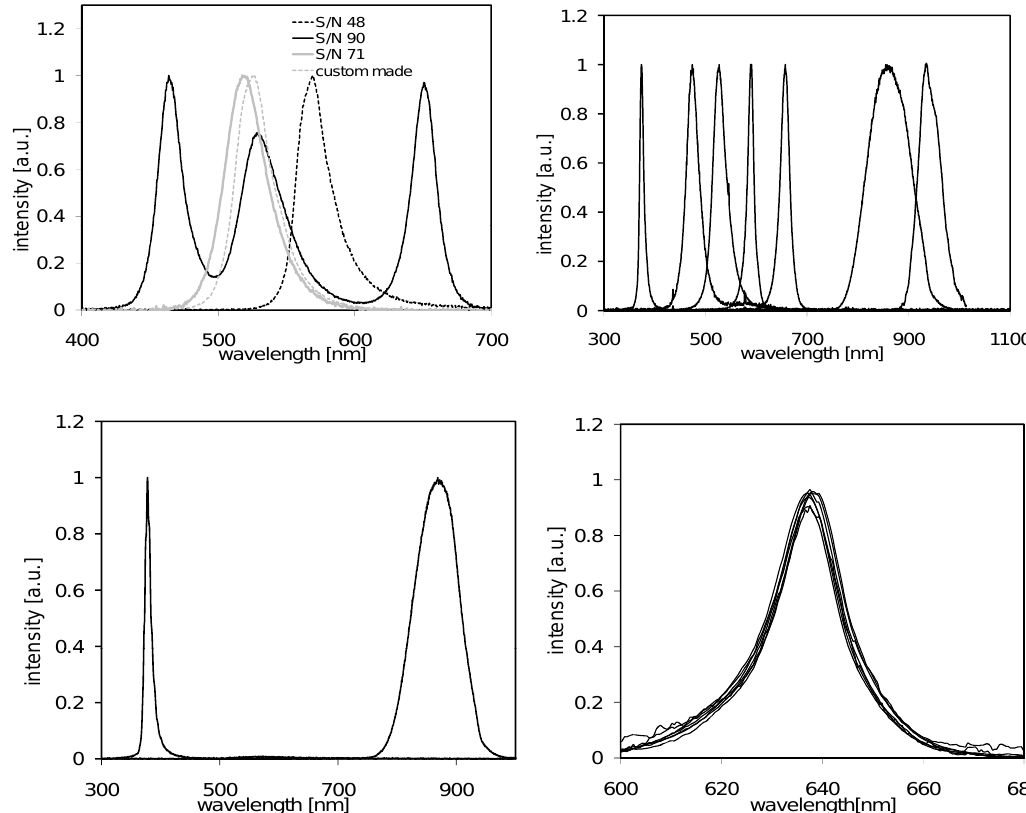
Fig. 4. Normalized spectral emission of light sources of absorption photometers. (a) different types of PSAPs; single wavelength Radi- ance Research PSAPs ( S/N 48, S/N 71); three wavelength Radiance Research PSAP ( S/N 90); custom made (ITM). (b) seven wavelength